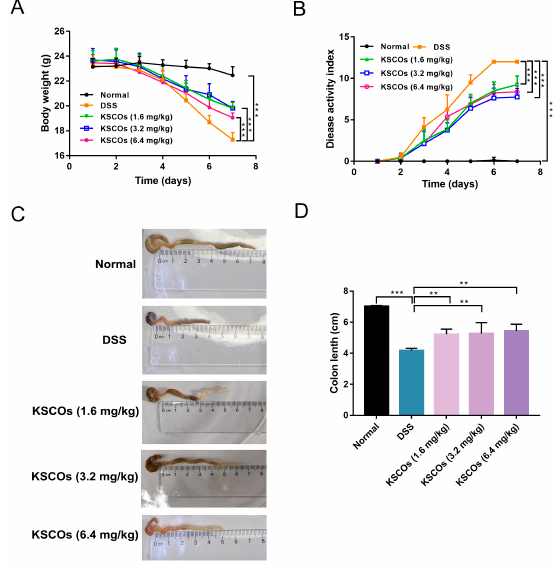
Figure 4. Symptoms of DSS-induced colitis: ( A ) body weight change; ( B ) disease activity index (DAI); ( C ) representative images of colon tissues; ( D ) colon length of different groups. Data are shown as means ± SD, ** p < 0.01, *** p <